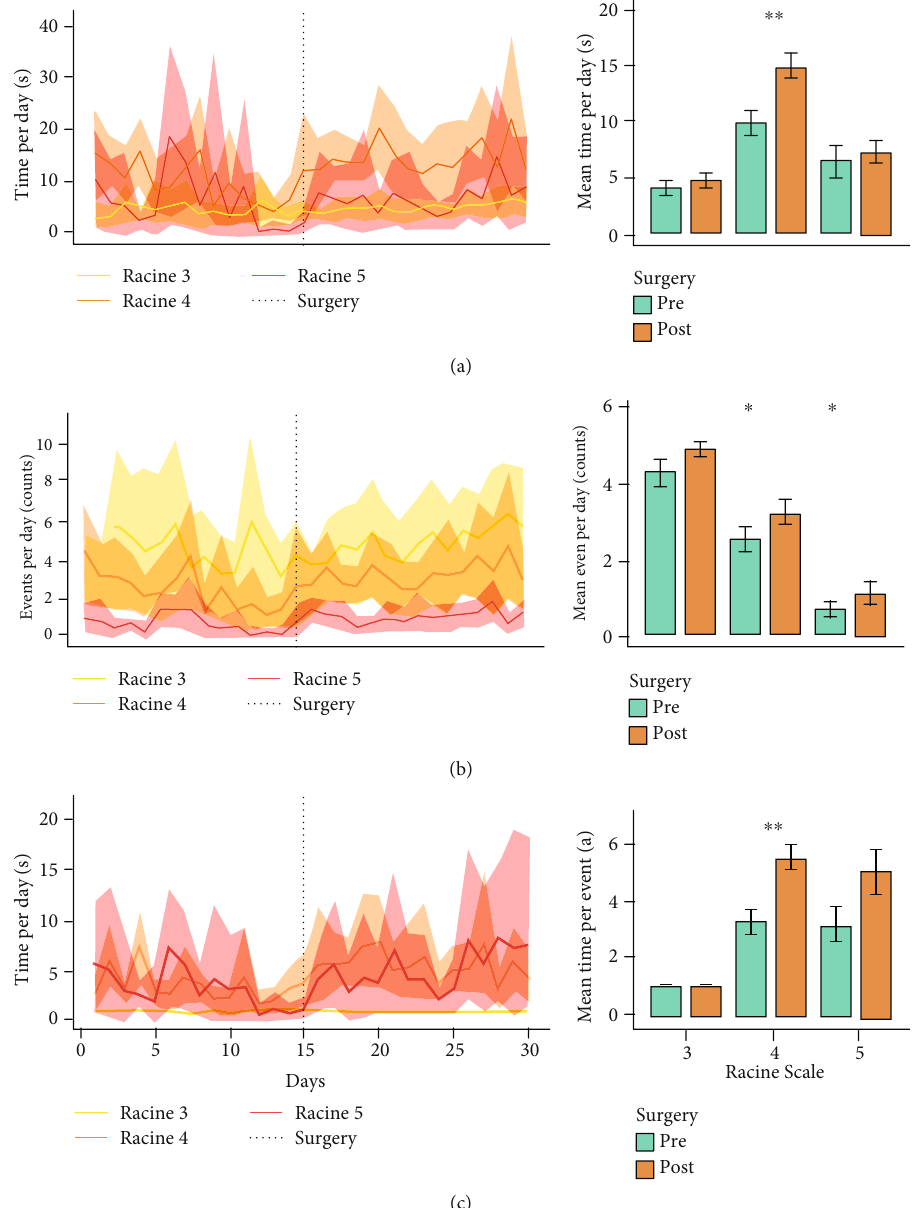
Figure 3: Analysis of the severity of convulsive behaviour according to the Racine scale before and after microelectrode implantation surgery. The line plots show the changes in the severity of convulsive behaviour as a function of time. The solid line represents the sample mean, and the shadowed region indicates the 95% con fi dence interval; the graphs at the right show comparisons of seizure severity (Racine scales 3, 4, and 5) before and after surgery. The t -test was used for all comparisons ( ∗ p < 0 : 05 , ∗∗ p < 0 : 01 , ∗∗∗ p < 0 : 001 , and ∗∗∗∗ p < 0 : 0001